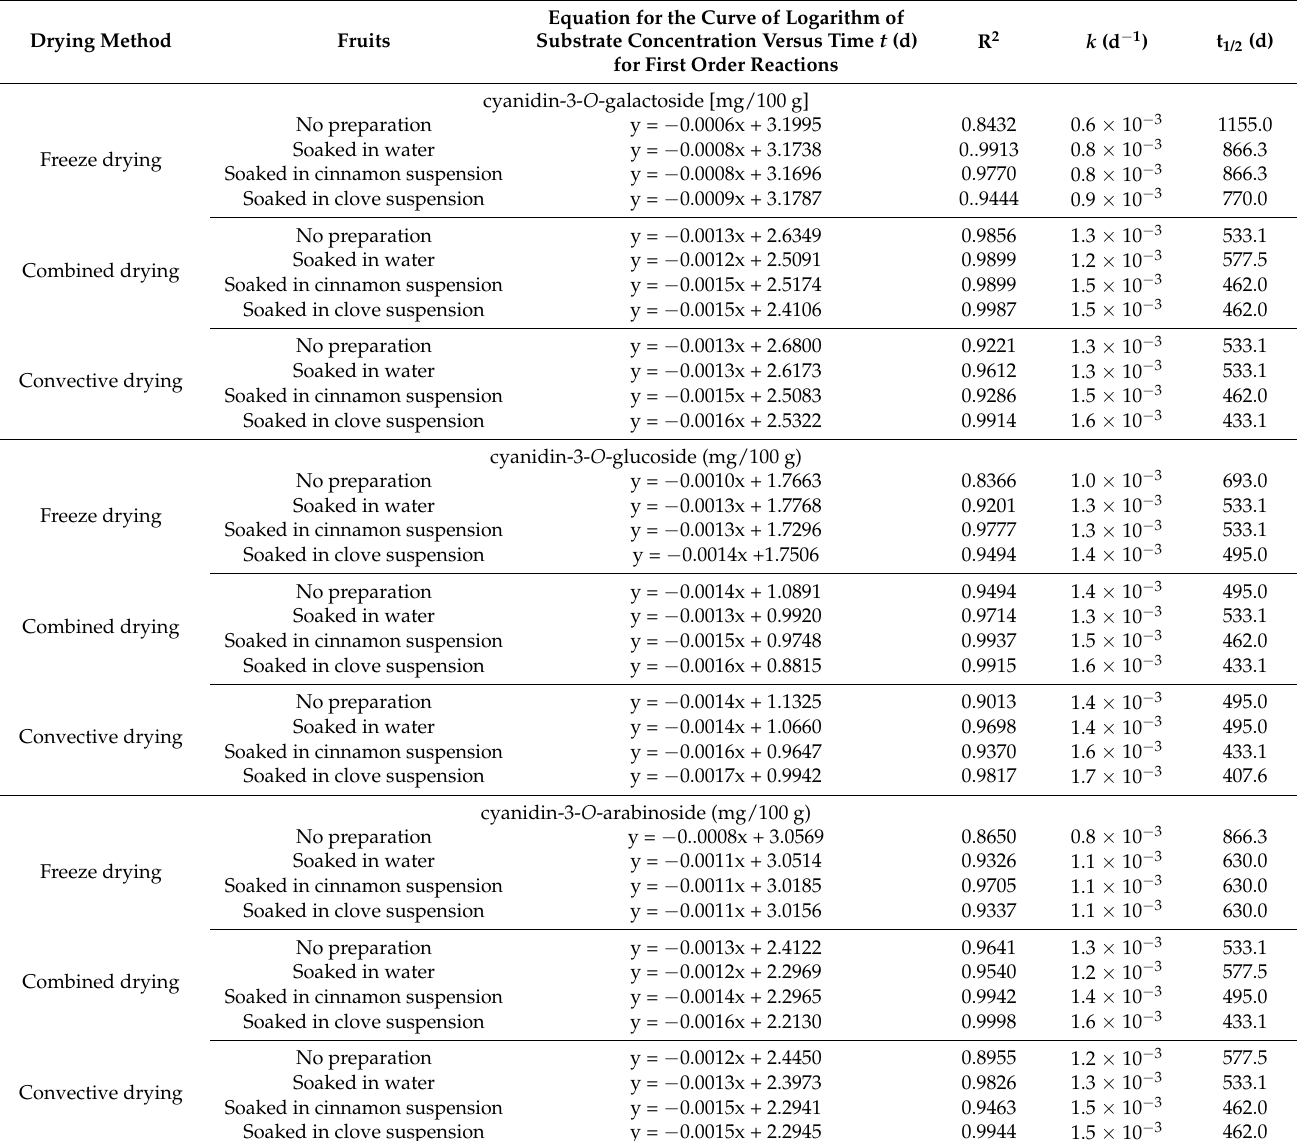
Table 5. Equation of the curve for degradation, constant reaction rate, and half-life of anthocyanins in dried chokeberry fruits. Drying